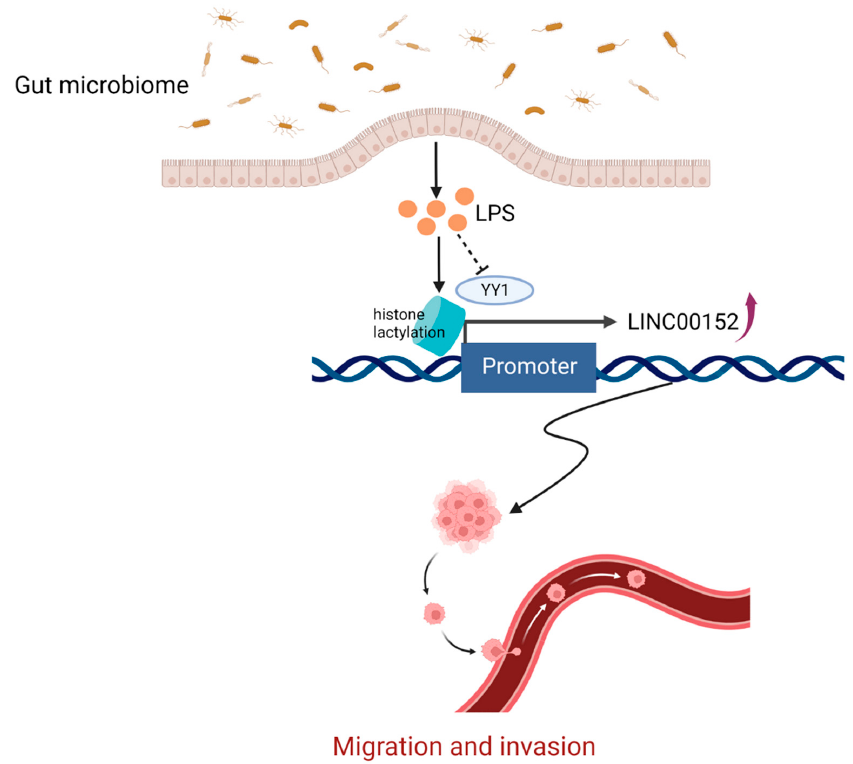
Figure 5. The gut microbiome-derived LPS promotes cancer cells migration and invasion by regulating LINC00152. The bacteria-derived LPS introduces histone lactonization on the promoter of LINC00152 and reduces the binding efficiency of YY1 to LINC00152, thus upregulating the expression of LINC00152. The LPS-induced overexpression of LINC00152 was associated with cancer cells migration and invasion. (Created with BioRender.com). LPS: